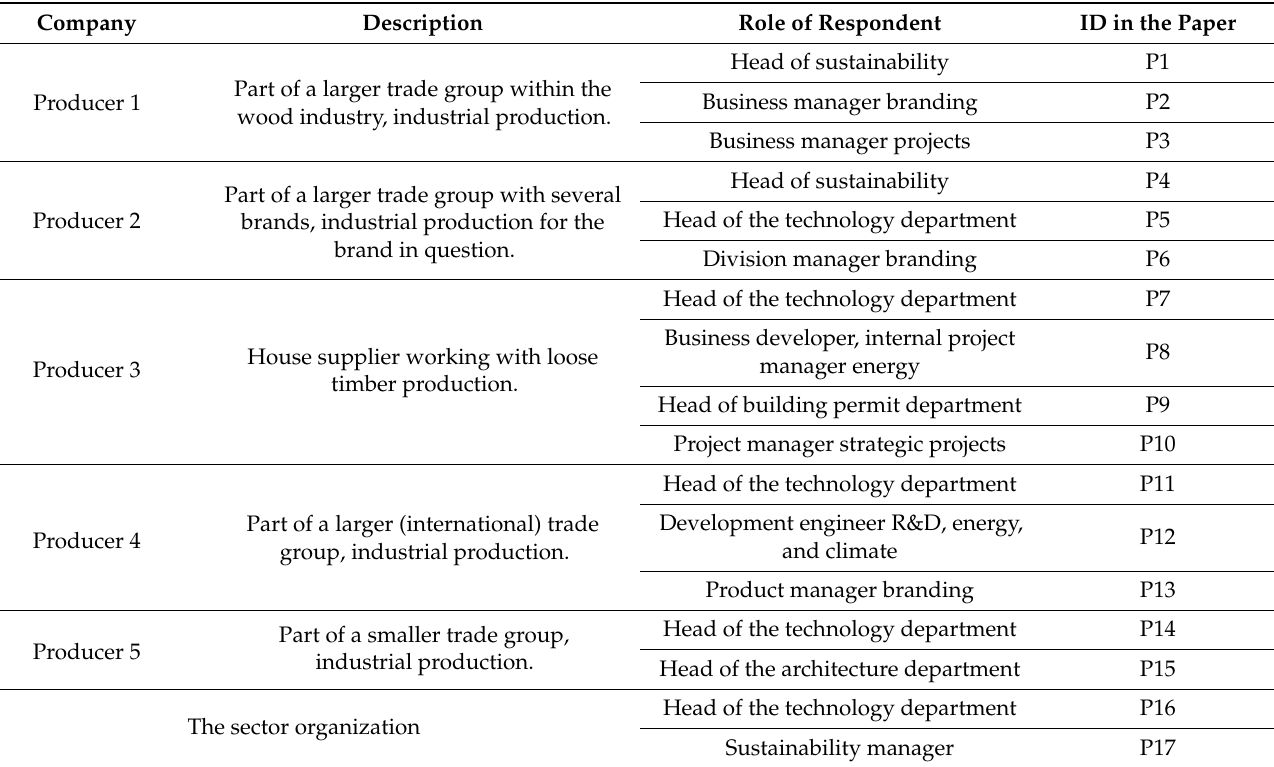
Table 1. Overview of studied companies and interviewed